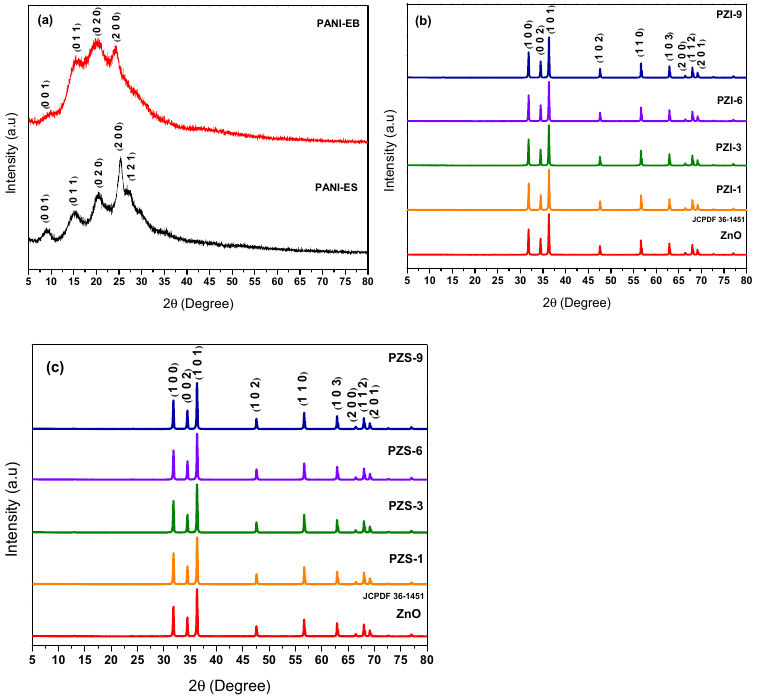
Figure 4. X-ray Diffraction (XRD) spectra of ( a ) PANI-ES and PANI-EB, ( b ) ZnO and PZI composites and ( c ) ZnO and PZS composites.